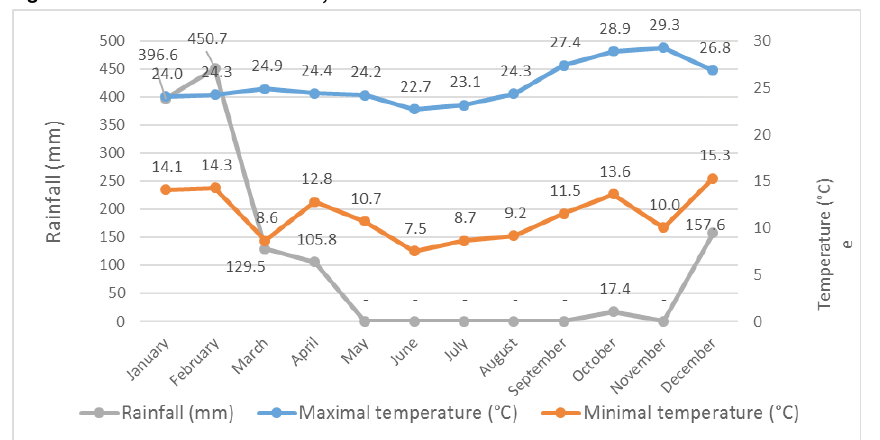
Figure 1: Intervention districts surveyed